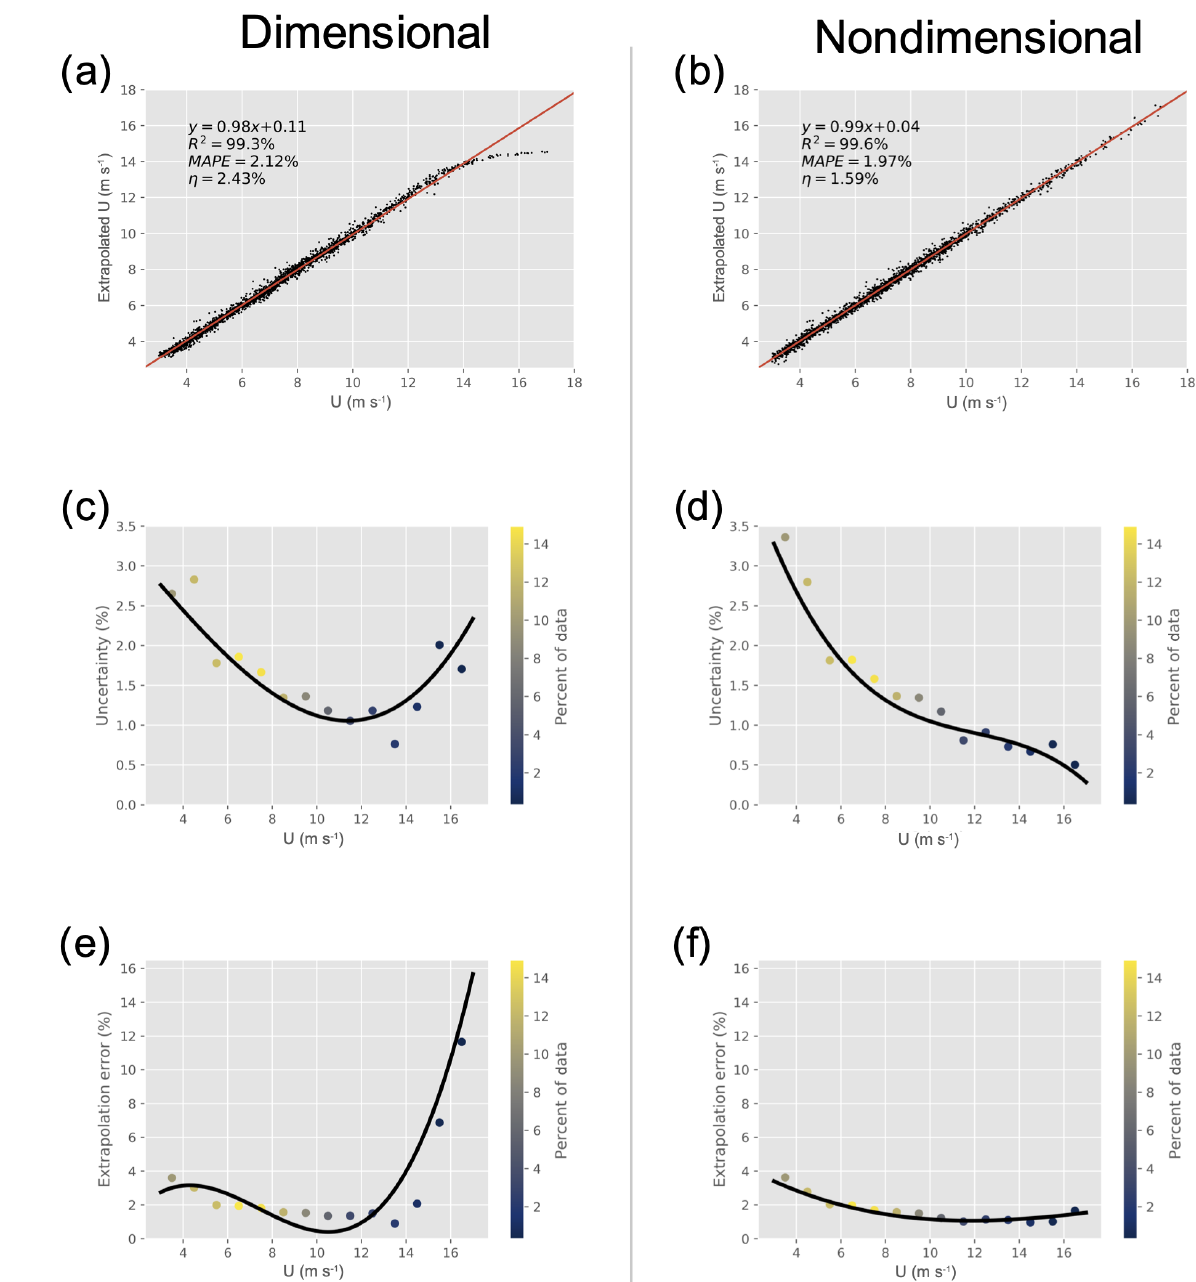
Figure 4. Comparison of network performance with dimensional (a, c, e) and nondimensional (b, d, f) input features for the 160m extrap- olation at Perdigão. The top row shows a comparison of true and extrapolated wind speed (at extrapolation height) with the best-fit line, the middle row the change in uncertainty with wind speed, and the bottom row the change in extrapolation error with wind speed. The black lines indicate a spline interpolation of the data. Colors indicate the percent of data at each binned wind speed for the testing